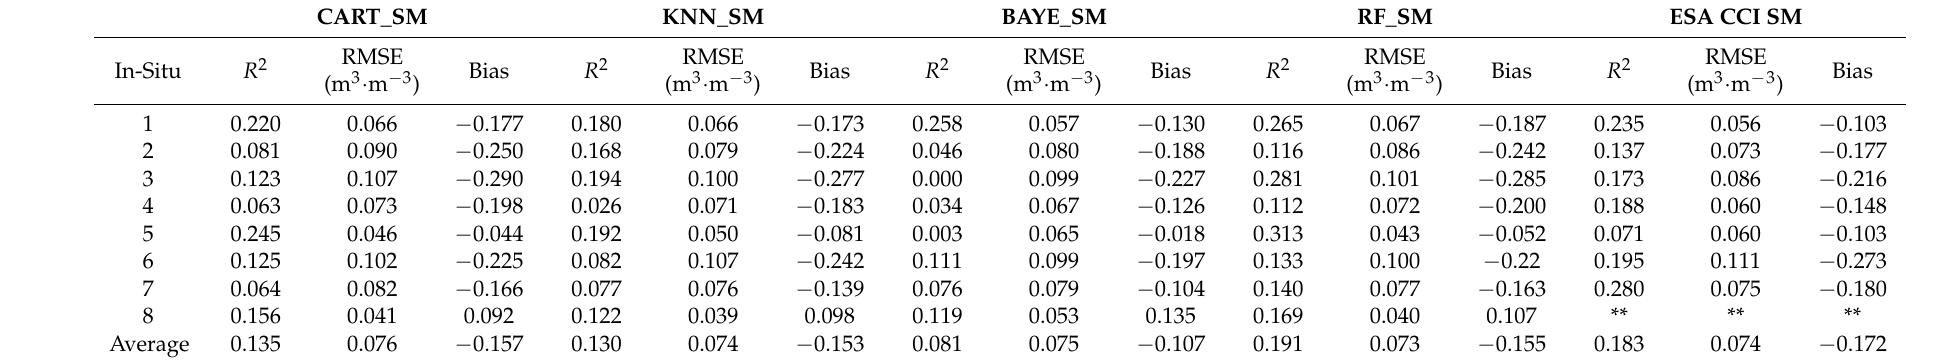
Table 3. Validation results of different downscaling methods in different soil moisture